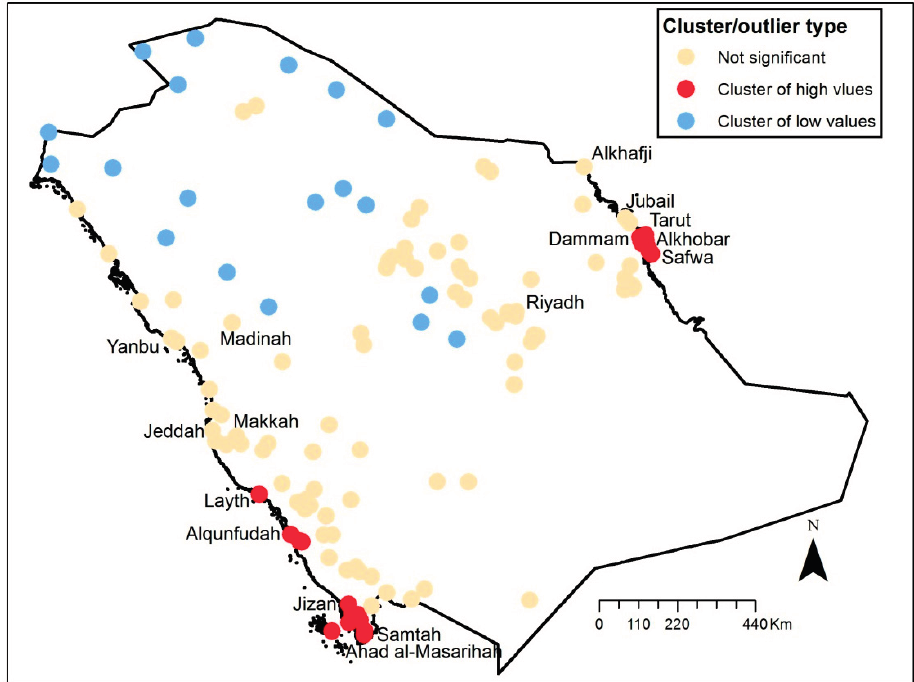
Figure 5. Clusters of PM 2.5 concentrations (un-weighted) in 2002.